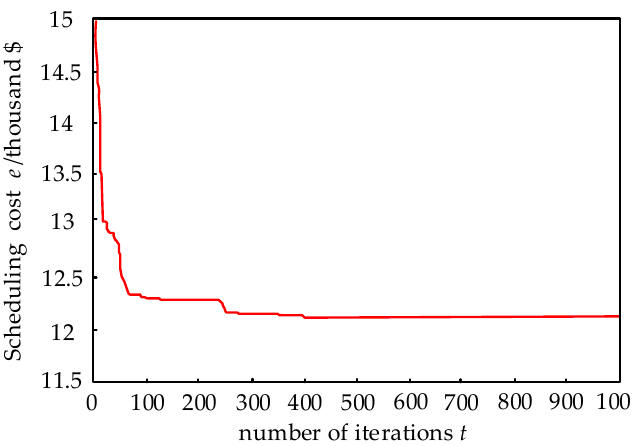
Figure 11. The change curve of economic costs with the number of iterations (SPSO).